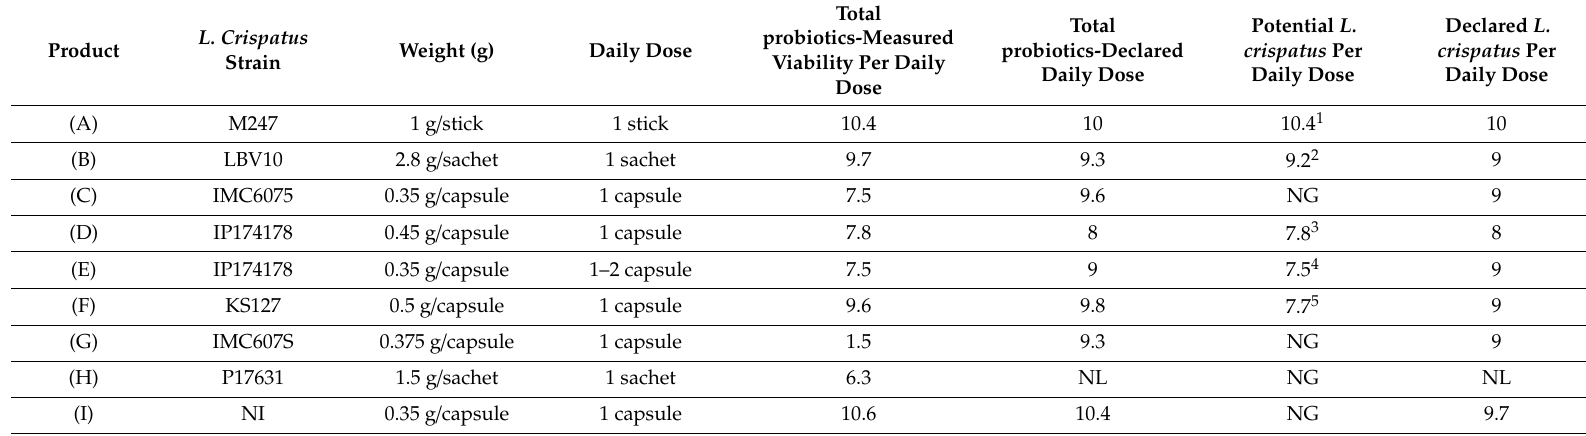
Table 3. Comparison of experimental viable counts (scaled to the weight per day) with the labelled daily dose for the total and L. crispatus viable counts expressed as 10 9 (CFU /